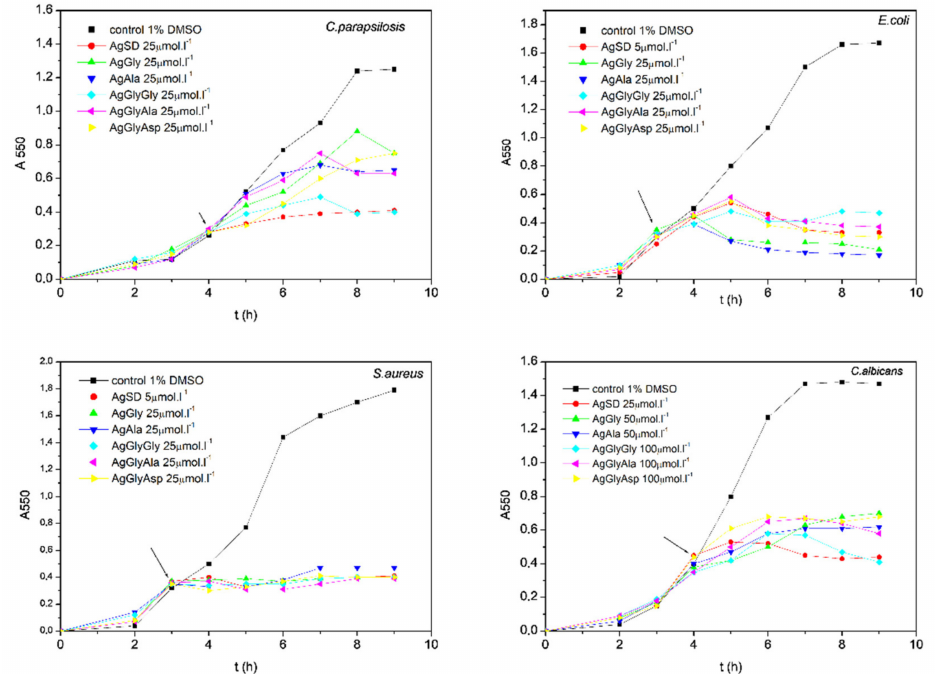
Figure 6. The growth inhibition after addition of the silver(I) complexes in the early exponential growth